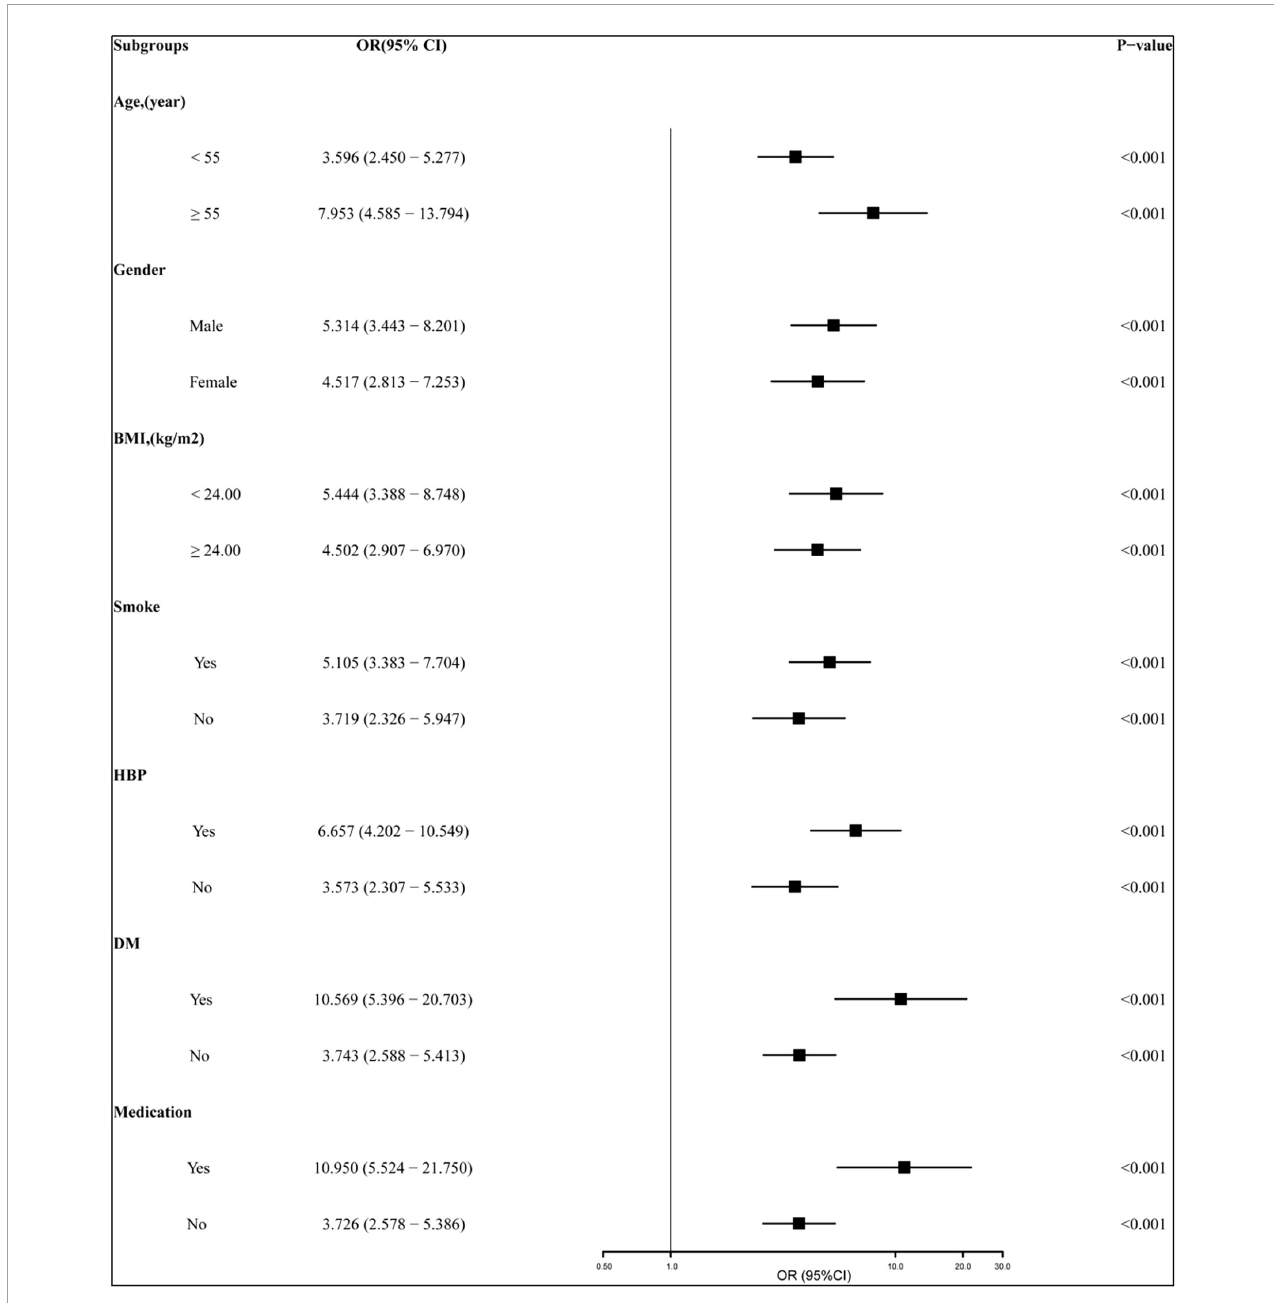
FIGURE5 Subgroup analyses of the relationship between pTG4h and non-optimal TG (NoTG). The study population was stratified by age ( < 55 years vs. ≥ 55 years), gender (male vs. female), BMI ( < 24 kg/m 2 vs. ≥ 24 kg/m 2 ), current smoking (yes vs. no), hypertension (yes vs. no), DM (yes vs. no),